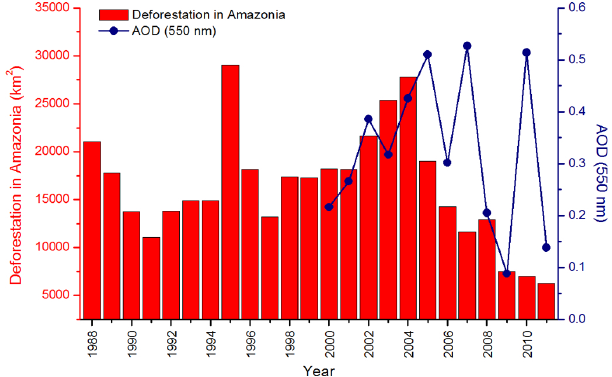
Fig. 1. Deforestation rate in Amazonia since 1988, showing the sharp decrease in Amazon deforestation since 2004 (red bars, data extracted from Prodes INPE, 2012). The blue points correspond to the mean AOD at 550nm, retrieved by MODIS during the biomass burning season over Amazonia. Notice that the aerosol loading does not follow the deforestation pattern. This indicates biomass burn- ing activities aimed at the maintenance of pasture and agricultural fields.